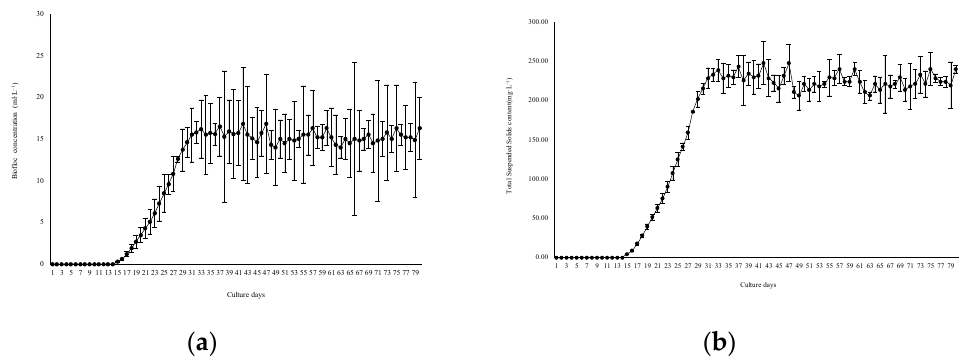
Figure 2. Biofloc concentration and Total Suspended Solids content during the experiment. ( a ) Biofloc concentration; ( b ) Total Suspended Solids content.